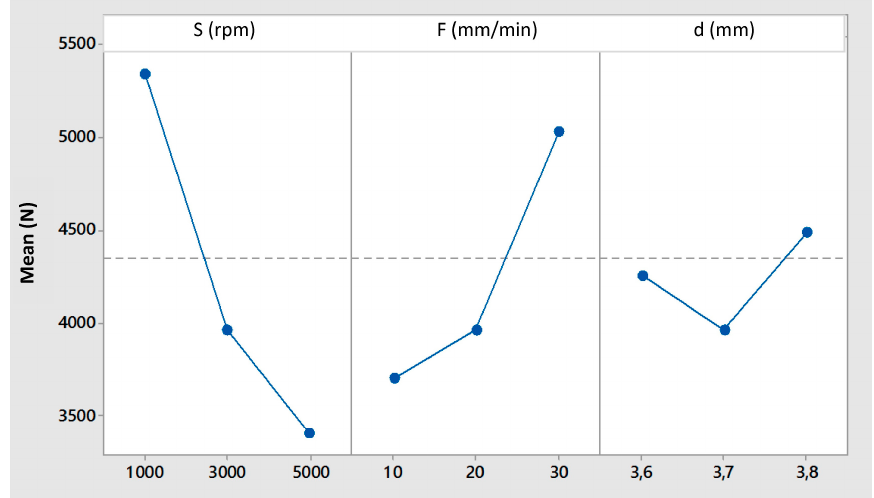
Figure 3. Main effects plot for welding forces.